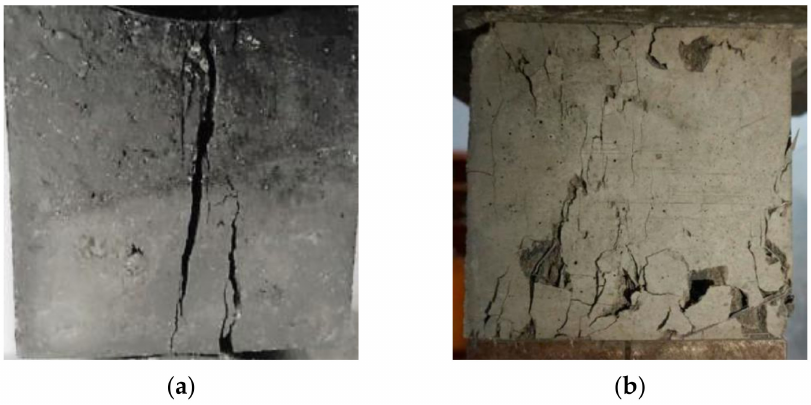
Figure 4. Compression failure of fiber-reinforced RAC: ( a ) [55]; ( b )